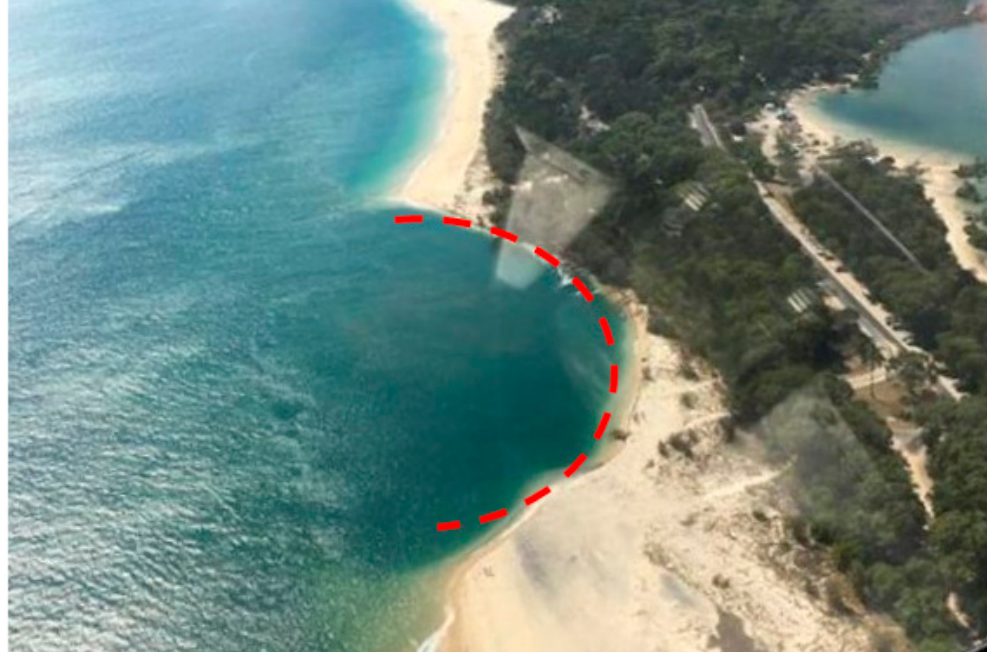
Figure 1. Aerial view of a large beach collapse (RBF event) at Inskip Point, Australia, 24 September 2018. The post-event scar in the beach is marked with the red dashed line. Photo: ABC News, Rainbow Beach Helicopters.